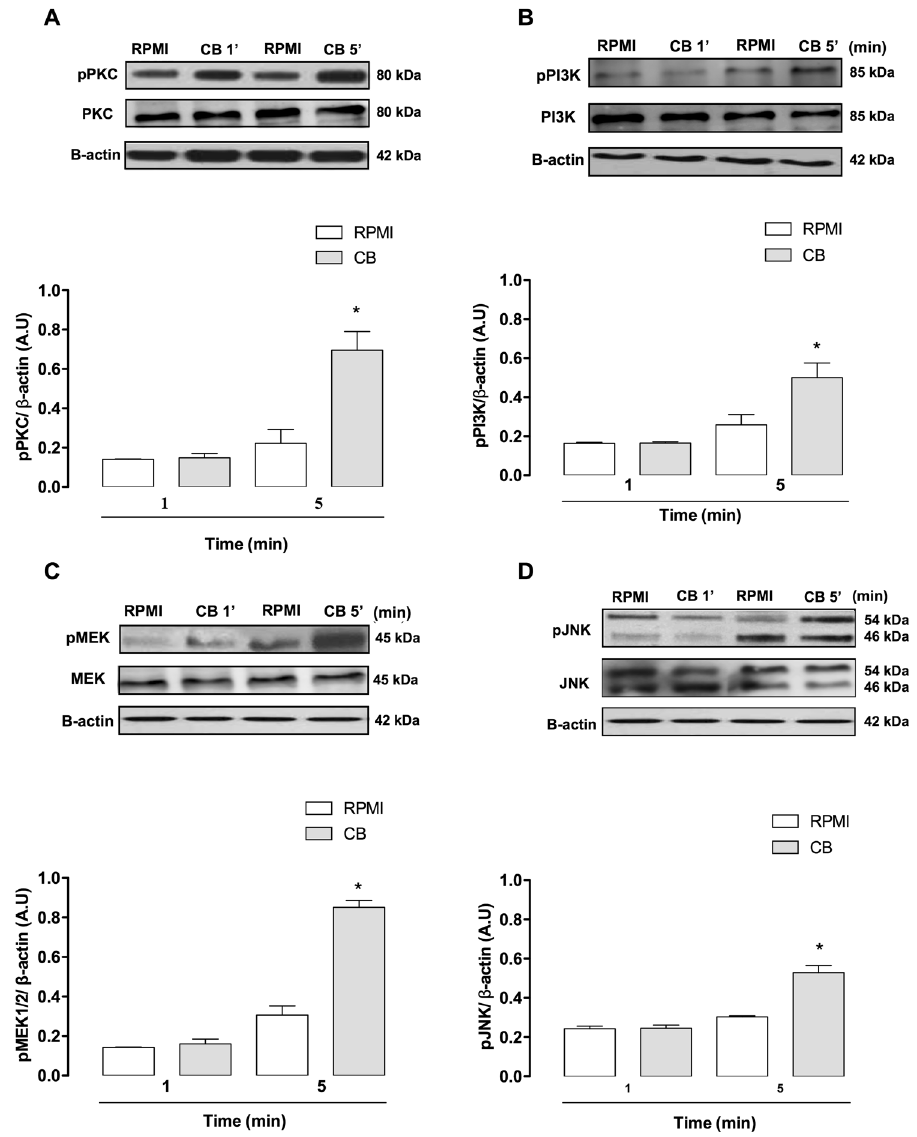
Figure 4. CB induces PKC, PI3K, MEK1/2 and JNK activation in isolated macrophages. Macrophages were incubated with CB (0.4 μ M) or RPMI (control) for 1 or 5 min. Western blotting of total and phospho-PKC ( A ), total and phospho- PI3K ( B ), total and phospho-MEK1/2 ( C ), total and phospho-JNK ( D ) and β -actin (loading control) in macrophage extracts. Densitometric analysis of the phosphorylated protein bands ( E , F , G and H ). The densities (in arbitrary units) were normalized with those of β -actin. Results are expressed as mean ± SEM for three experiments. * p < 0.05 compared with RPMI-stimulated